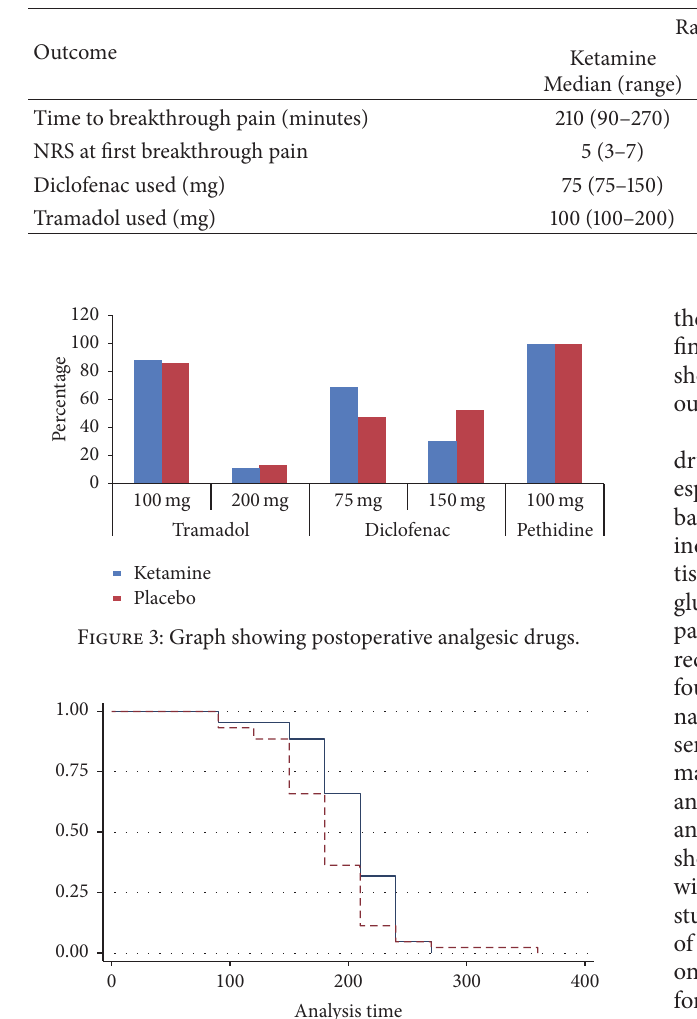
Table 2: Showing primary and secondary outcomes.